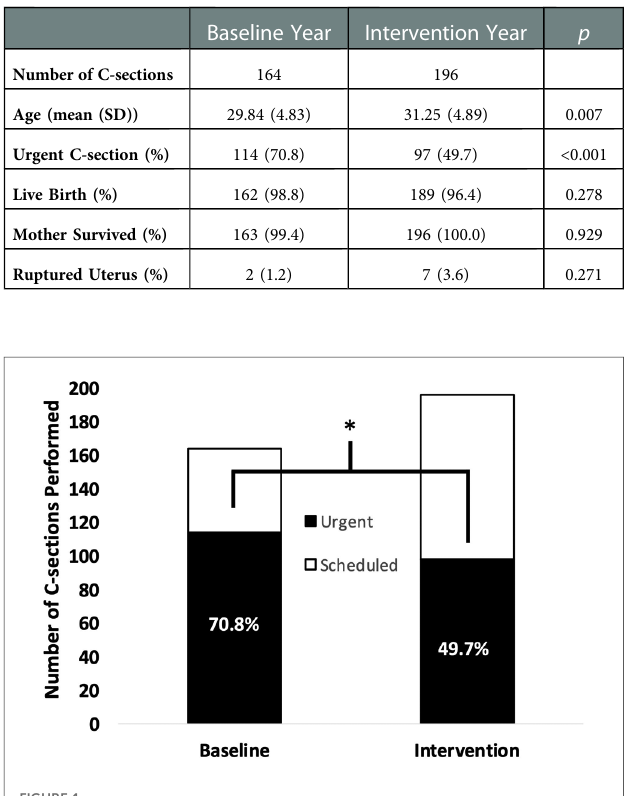
FIGURE 1 Differences in urgent vs. scheduled repeat cesarean section in baseline and intervention periods for women within the Kibuye district. *= p